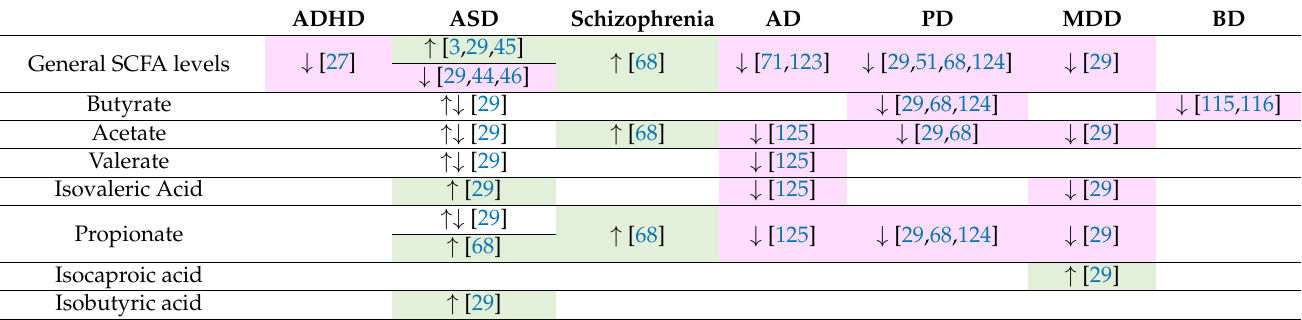
Table 10. A compilation of the literature on SCFA level aberrations in the different diseases when compared to healthy individuals. “ ↑ ” on a light green background symbolises an increase in the corresponding SCFA. A light red background with “ ↓ ” stands for a decrease, respectively. Cells containing “ ↑↓ ” imply that the findings were inconsistent and changes in patients suffering from the disease went in both directions. If no literature could be found, the cells remained